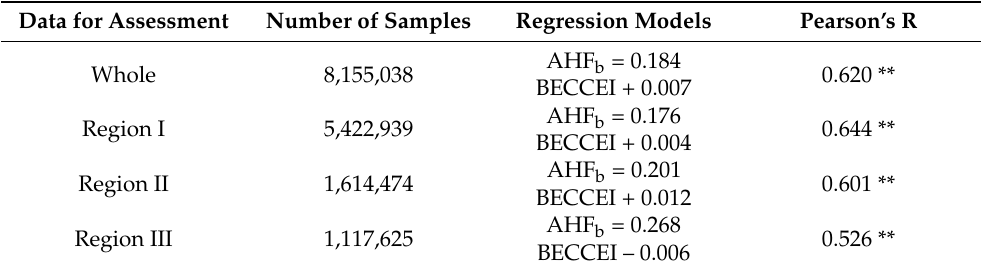
0.620 ** 0.644 ** 0.601 ** 0.526